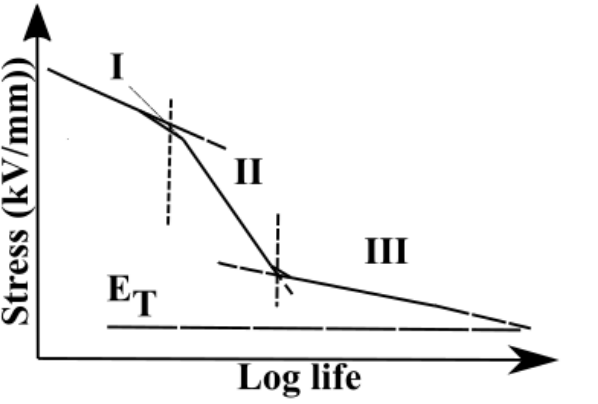
Figure 6. Representation of flat Z characteristics of insulation life in three regions adapted with permission from [44].